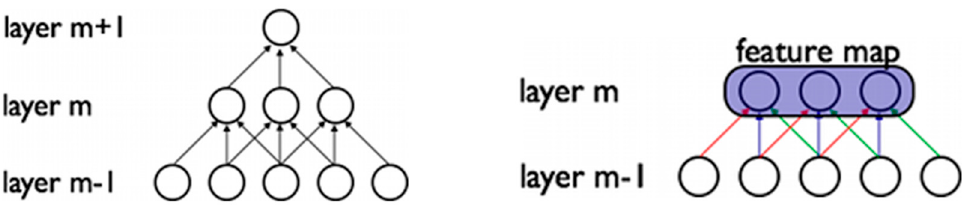
Figure 3. Convolutional layers that extract features of the input to create a feature map. The artificial neurons are represented by the circles, and the weights by the narrows. Weights of the same color are shared, constrained to be identical [56].